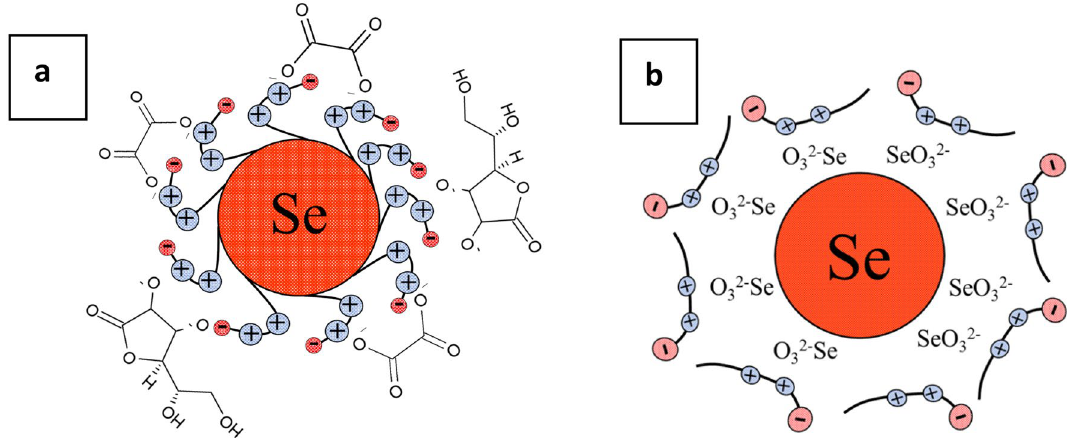
Figure 2. Structure of micelles of Se NPs stabilized with CAPB: ( a ) the positive sol micelle; ( b ) the negative sol